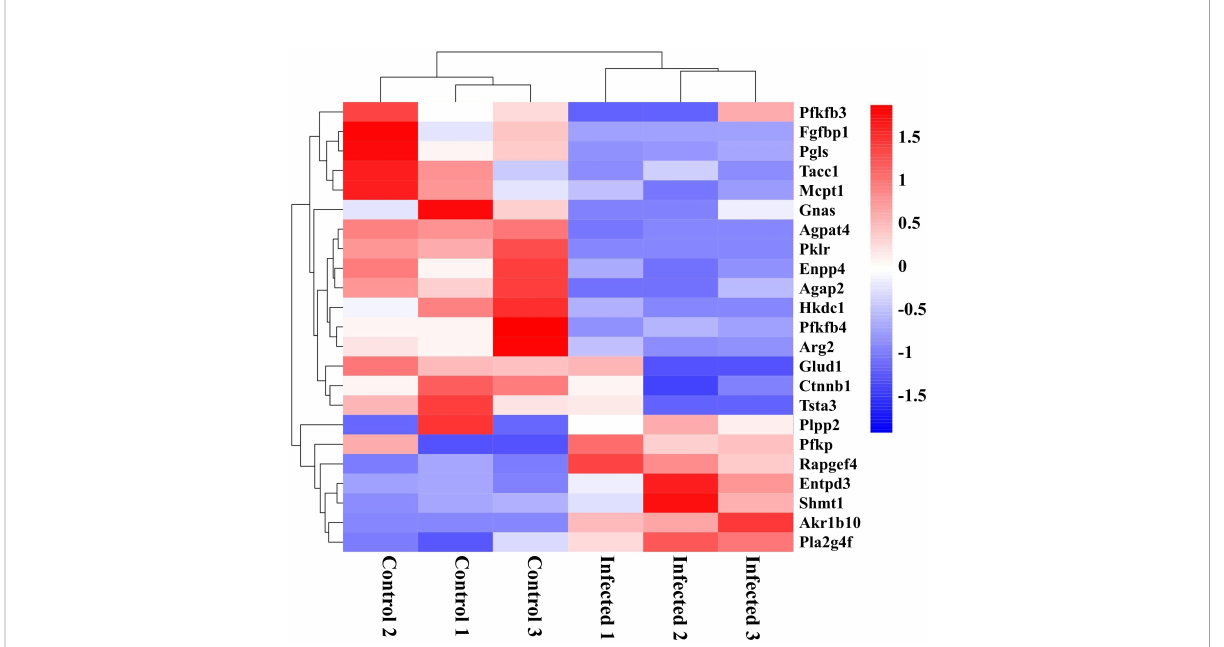
FIGURE 7 Clustering heatmap of differential metabolism-related mRNAs in the colon post the protoscoleces of Echinococcus granulosus infection. Red color means the upregulated mRNAs, and blue color means the downregulated